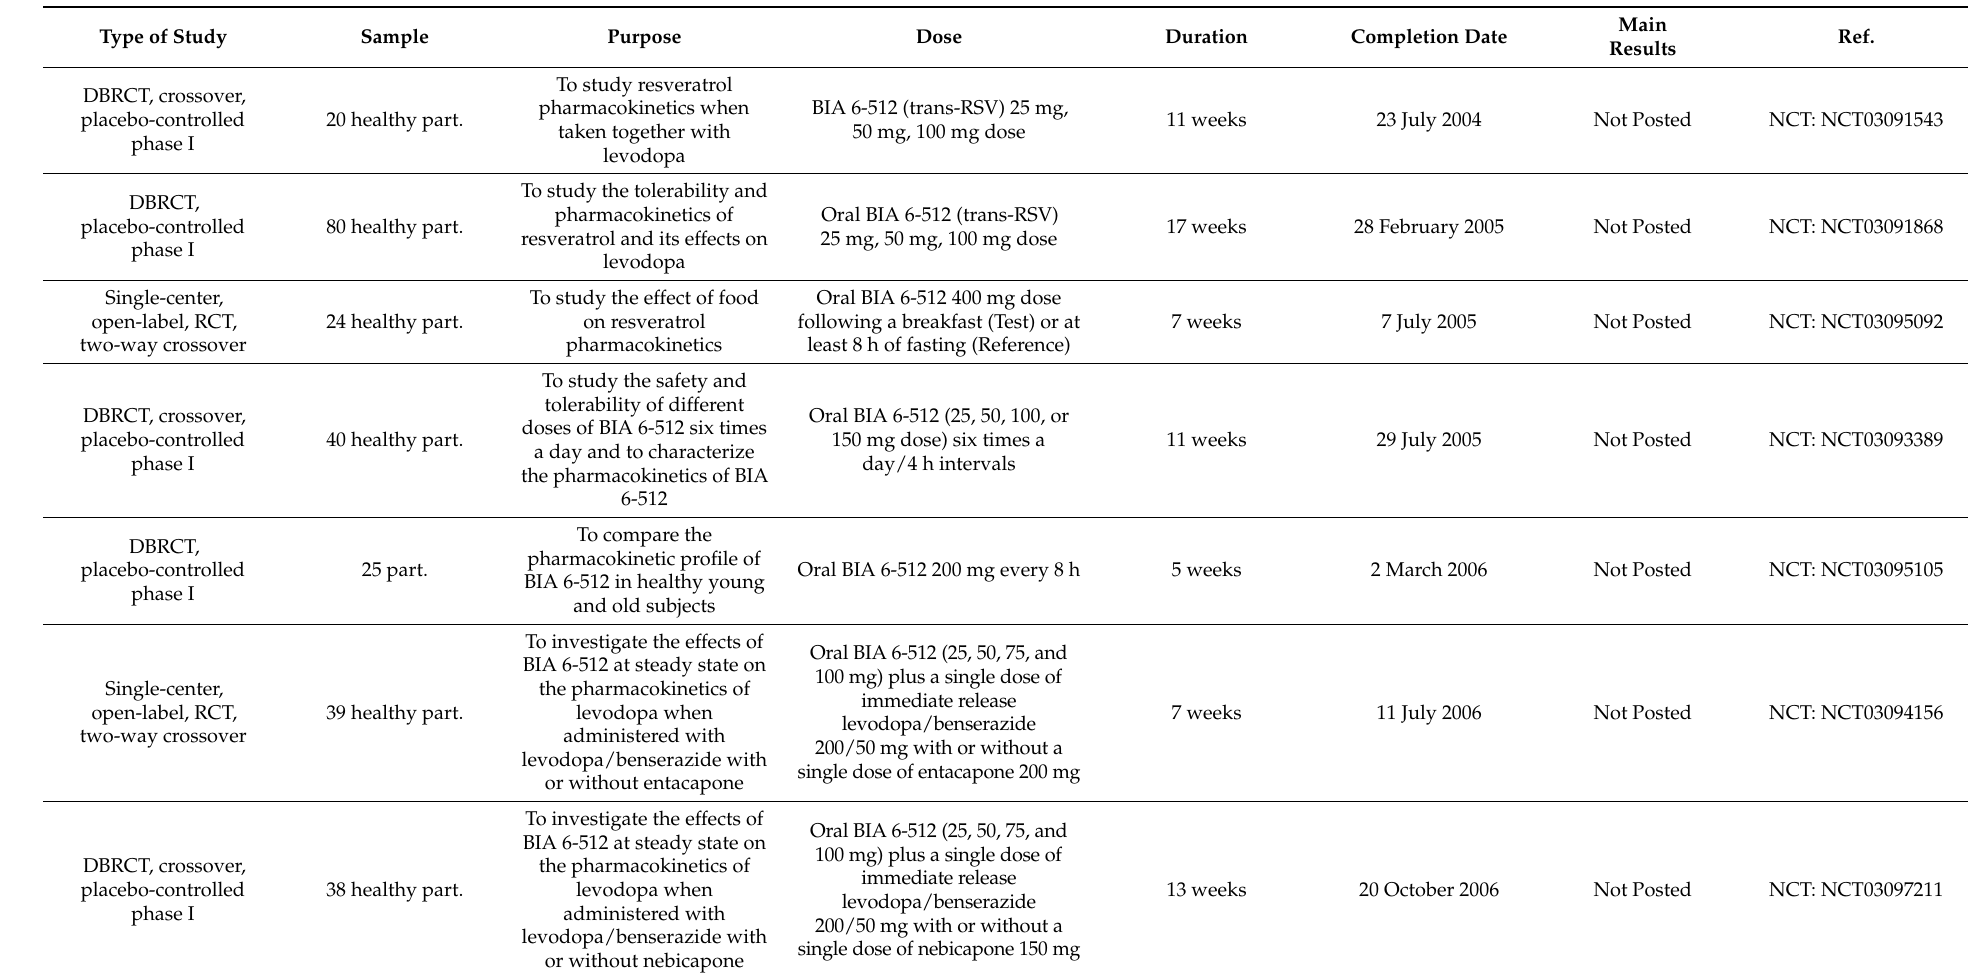
Table 2. Clinical trials of resveratrol on